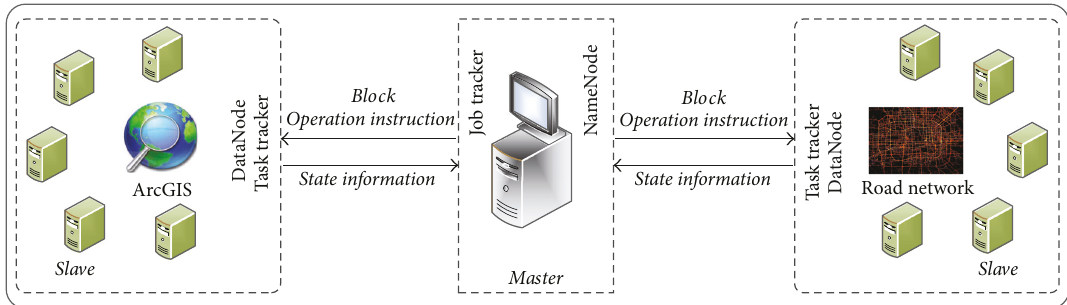
Figure 4: The experimental platform based on Hadoop with MapReduce, road network, and ArcGIS.